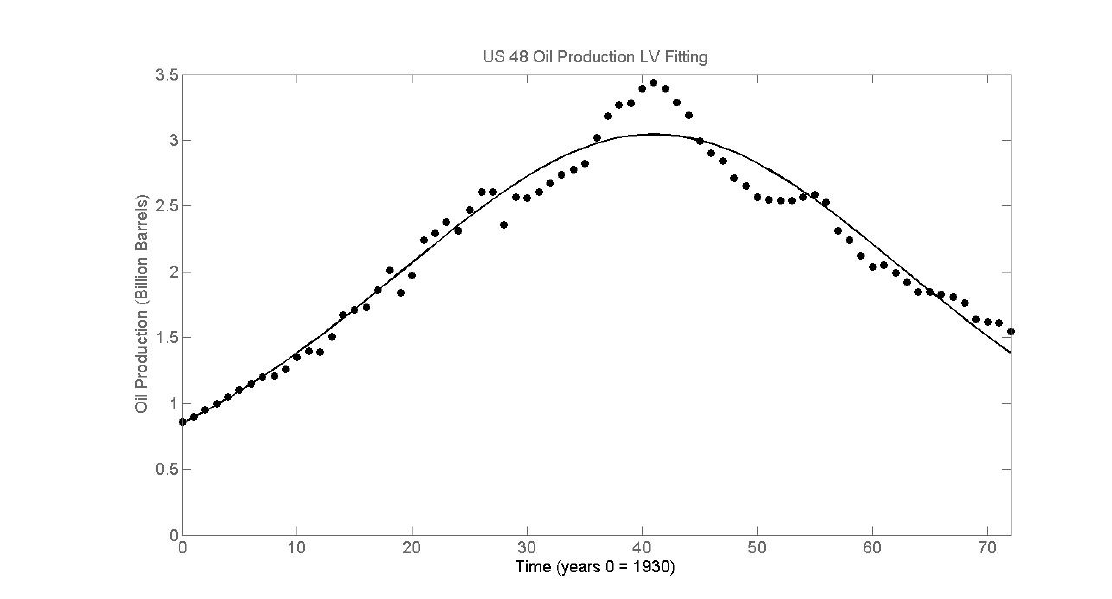
Figure 2 . Oil production in the US lower 48 states, fitted using the model developed in the present paper (data courtesy of Mr. Colin